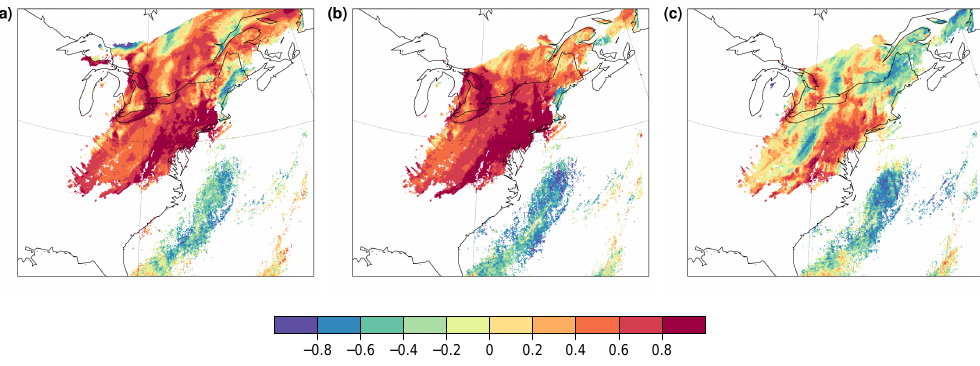
Fig. 13. (a) Correlation coefficients between time series of 2-meter temperature and δ 18 O in hourly precipitation from the COSMO iso reference simulation. Values are only shown at grid points with 15 or more hours of precipitation (meaning that the simulated precipitation is larger than 0.1mm per hour). (b) Correlation coefficients between time series of the height above ground of the 0 ◦ C isoline and δ 18 O in hourly precipitation. (c) As in (b) , but for the sensitivity experiment in which isotopic fractionation during the interaction of rain drops and the surrounding water vapour is switched off. In (b) and (c) , in addition to grid points with too little precipitation hours, also points are masked where the temperature on the lowest model level is always below 0 ◦